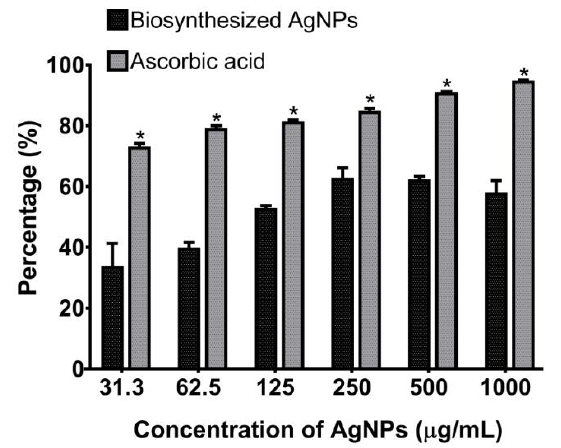
Figure 8. Antioxidant activity of biosynthesized AgNPs. Ascorbic acid was used as a positive control. Each value represents the mean ± SD of three replicates. * p <